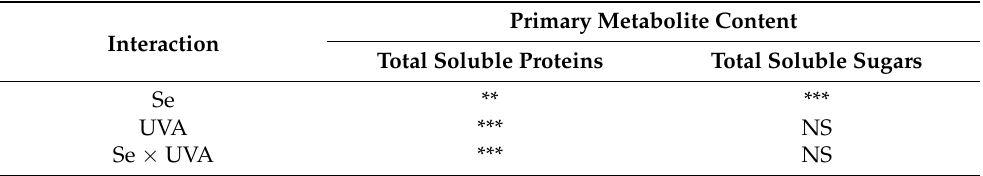
Table 4. The interaction effects of Se and UVA on antioxidant content and capacity of broccoli mi- crogreens.